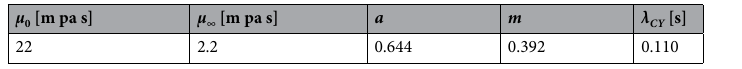
Table 1. Parameters used for the Carreau–Yasuda model 45 .